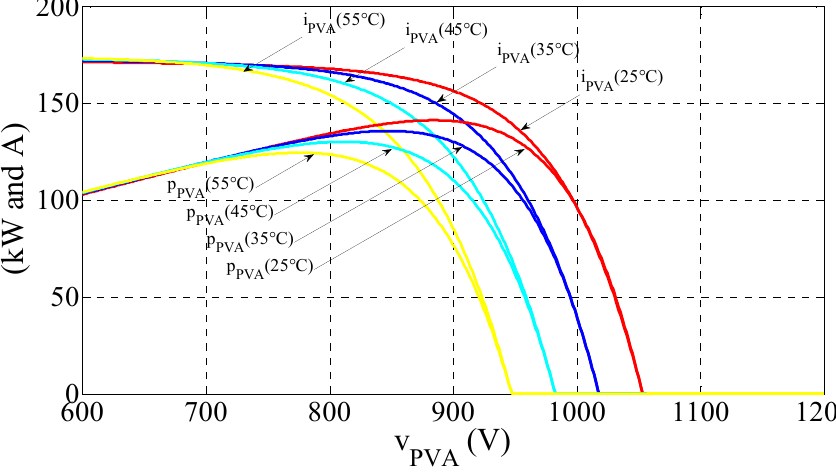
Figure 4. PVA power and current under 1000 W/m 2 irradiance and for different PV cell